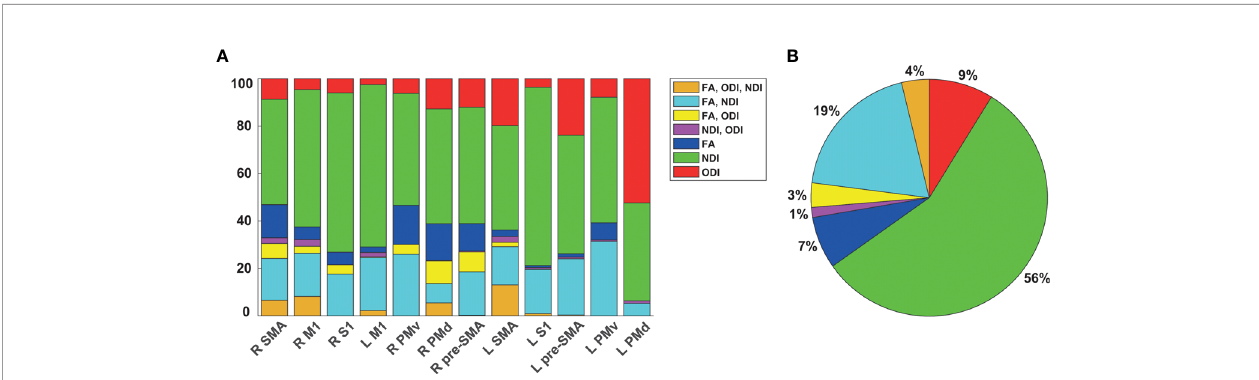
FIGURE 5 | Comparison of diffusion parameters contributing to observed group differences. (A) Percentage of FA, NDI and ODI separately or combined showing group differences in the tract skeleton in intersection with SMATT regions. (B) Percentage averaged over regions with any signi fi cant group difference (B) . FA, fractional anisotropy, NDI, neurite density index, ODI, orientation dispersion index, SMA, supplementary motor area, M1, primary motor cortex, S1, primary somatosensory cortex, PMv, ventral premotor cortex. PMd, dorsal premotor cortex.